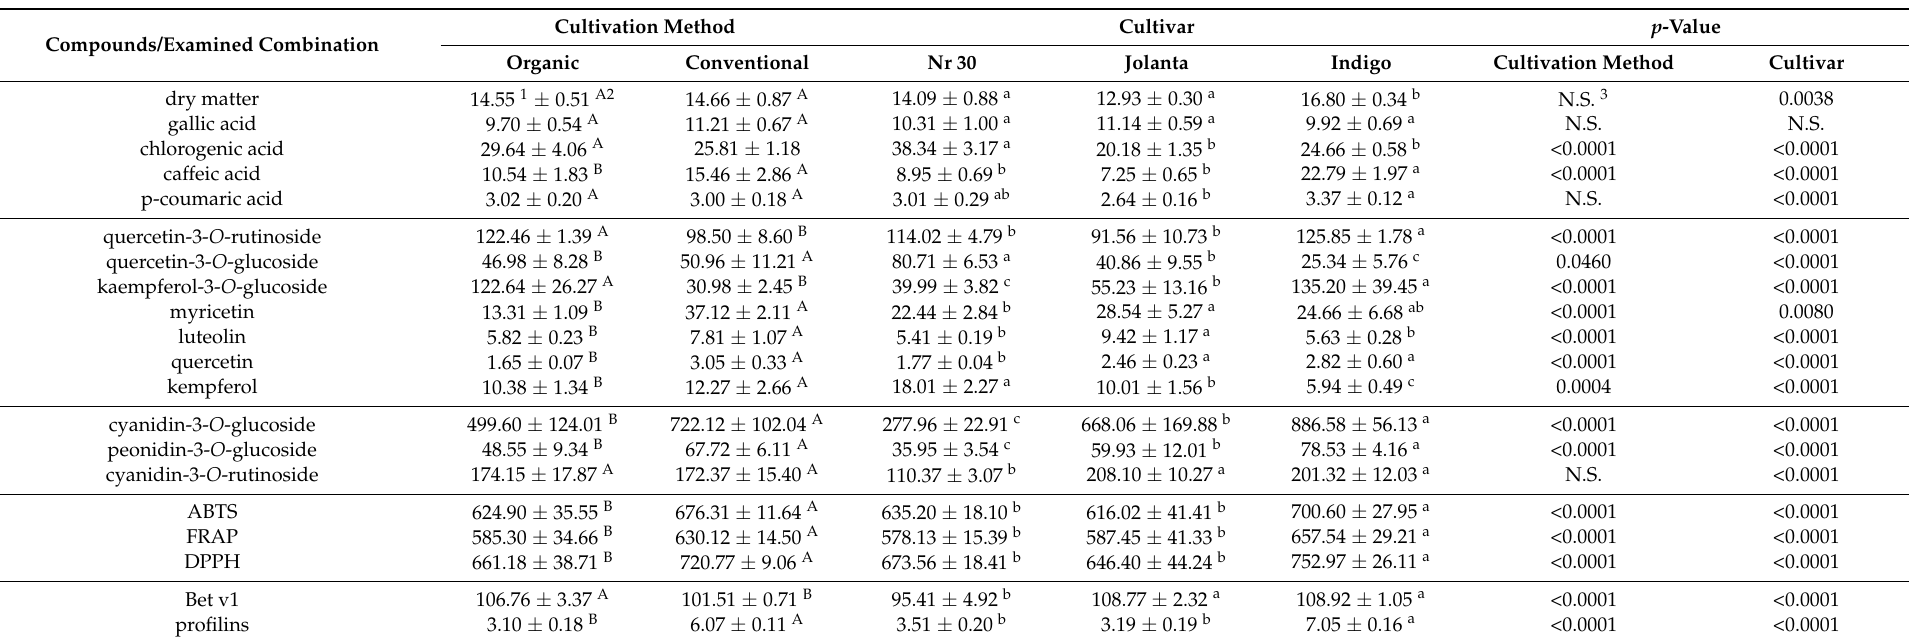
Table 2. The content of dry matter in (g 100 g − 1 F.W.), polyphenols (mg 100 g − 1 D.W.), antioxidant activity ( µ M TEAC g − 1 D.W.), Bet v1 (ng g − 1 D.W.) and profilins ( µ g g − 1 D.W.) in examined blue honeysuckle fruits in